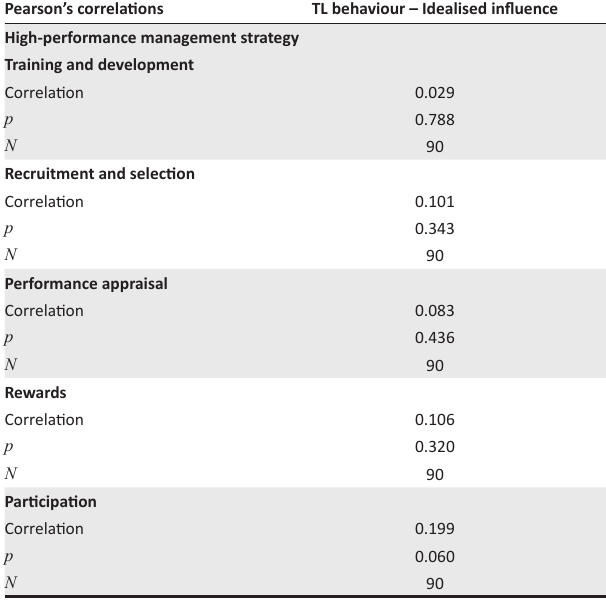
TABLE 4: Correlations of transformational leadership behaviour – Idealised influence and high-performance management strategy.